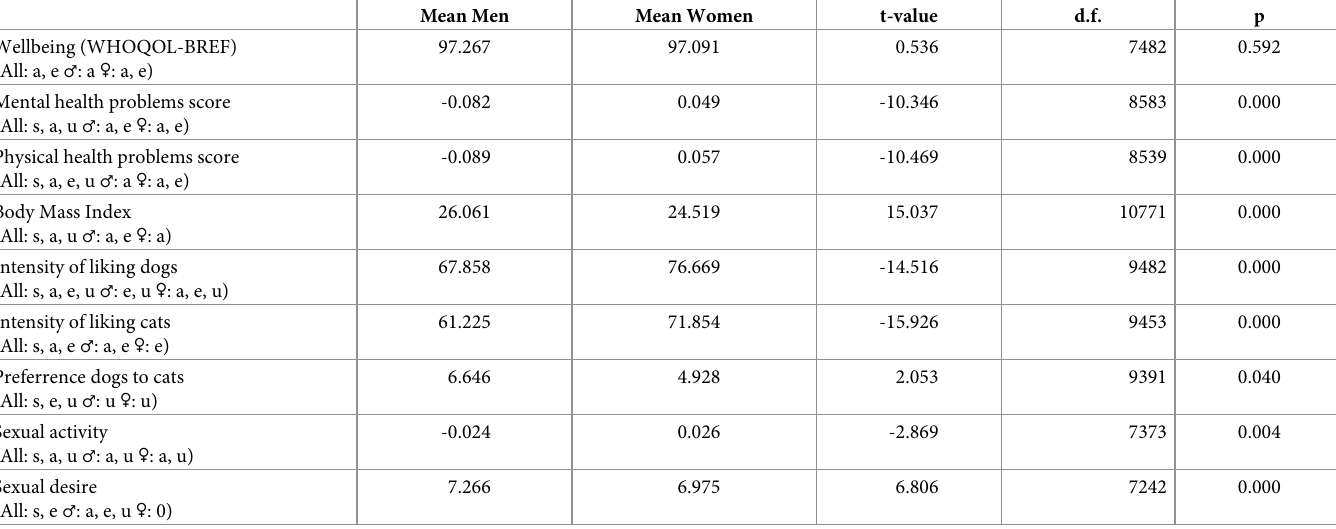
Table 3. Continuous depending variables—Difference between men and women.